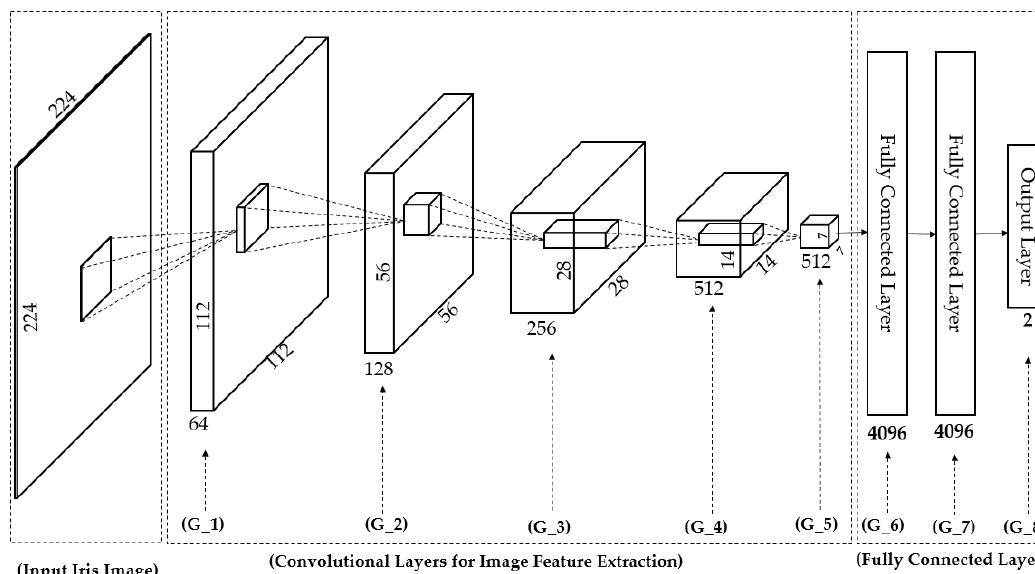
Figure 7. Visualization of convolutional neural network architecture in Table 2.